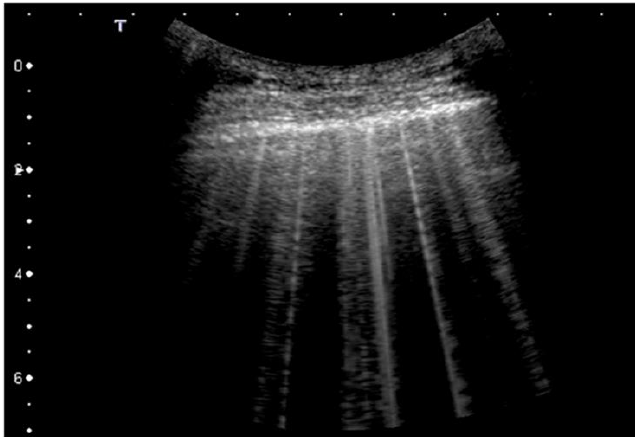
Figure 2. B-lines with variable appearance (cardiogenic pulmonary edema). B-lines are qualitatively characterized by their brightness, the full screen extension, the pleural origin, and the presence or absence of internal modulation. Convex probe, 6 MHz.